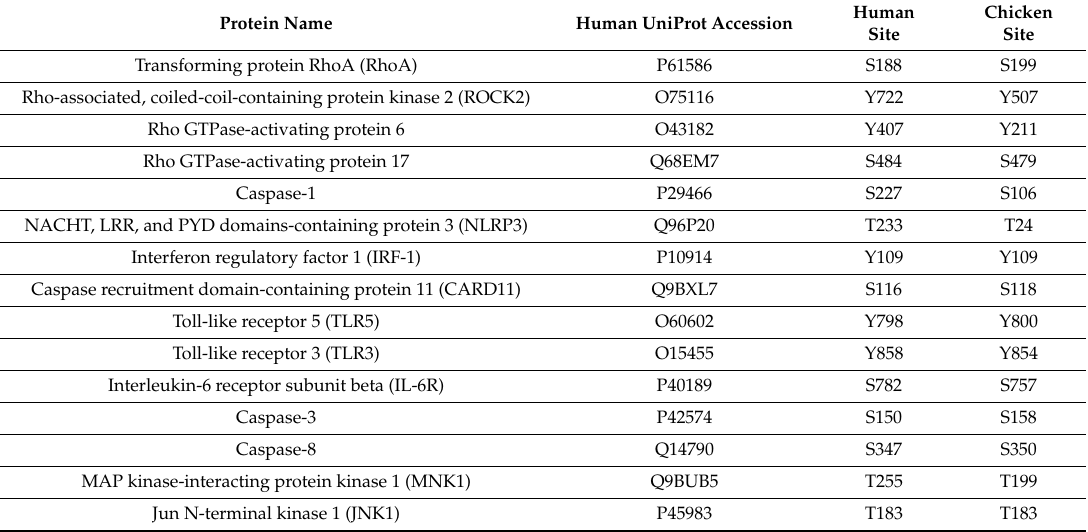
Table A1. Protein names and chicken phosphorylation sites corresponding to the human sites reported in this